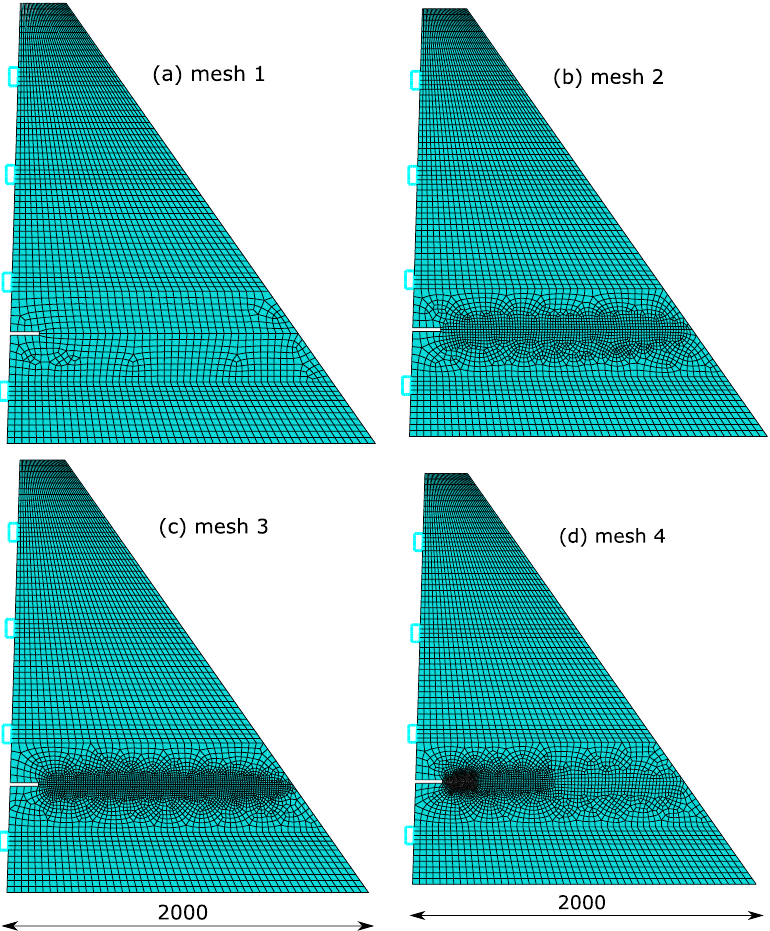
Figure 4. Different levels of refinement applied for the finite element modeling: ( a ) mesh 1, ( b ) mesh 2, ( c ) mesh 3, ( d ) mesh 4. Dimensions: mm.